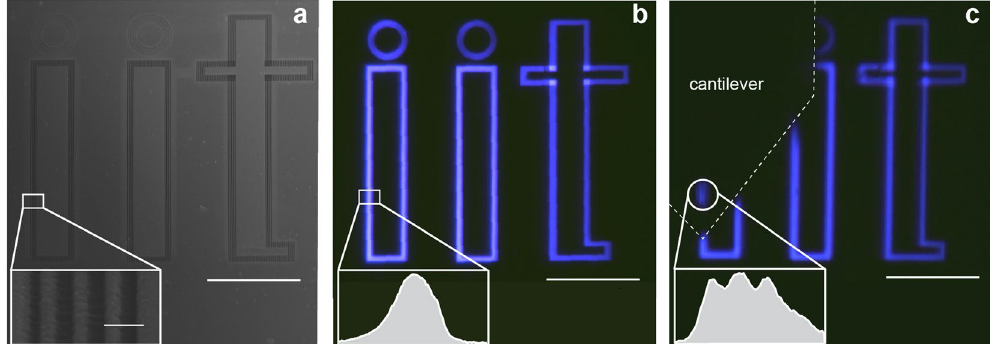
Figure 1. Traditional imaging versus microbead imaging. ( a ) SEM micrograph of a structure consisting of the “iit” logo. As shown in the inset, each letter consists of equally spaced lines with a periodicity of 380 nm. Scale bar is 20 µ m, inset scale bar is 500 nm. ( b ) Optical image of the structure using 450 nm transmitted illumination with a 50 × , 0.5 NA. Scale bar is 20 µ m. The periodic lines of each letter cannot be resolved, as shown in the intensity plot of the inset. ( c ) Virtual image obtained using the microbead. Scale bar is 20 µ m. In this case, the image formed through the microbead can resolve the periodic lines (inset). Note that due to the limited field of view of the microbead, only 3 lines are